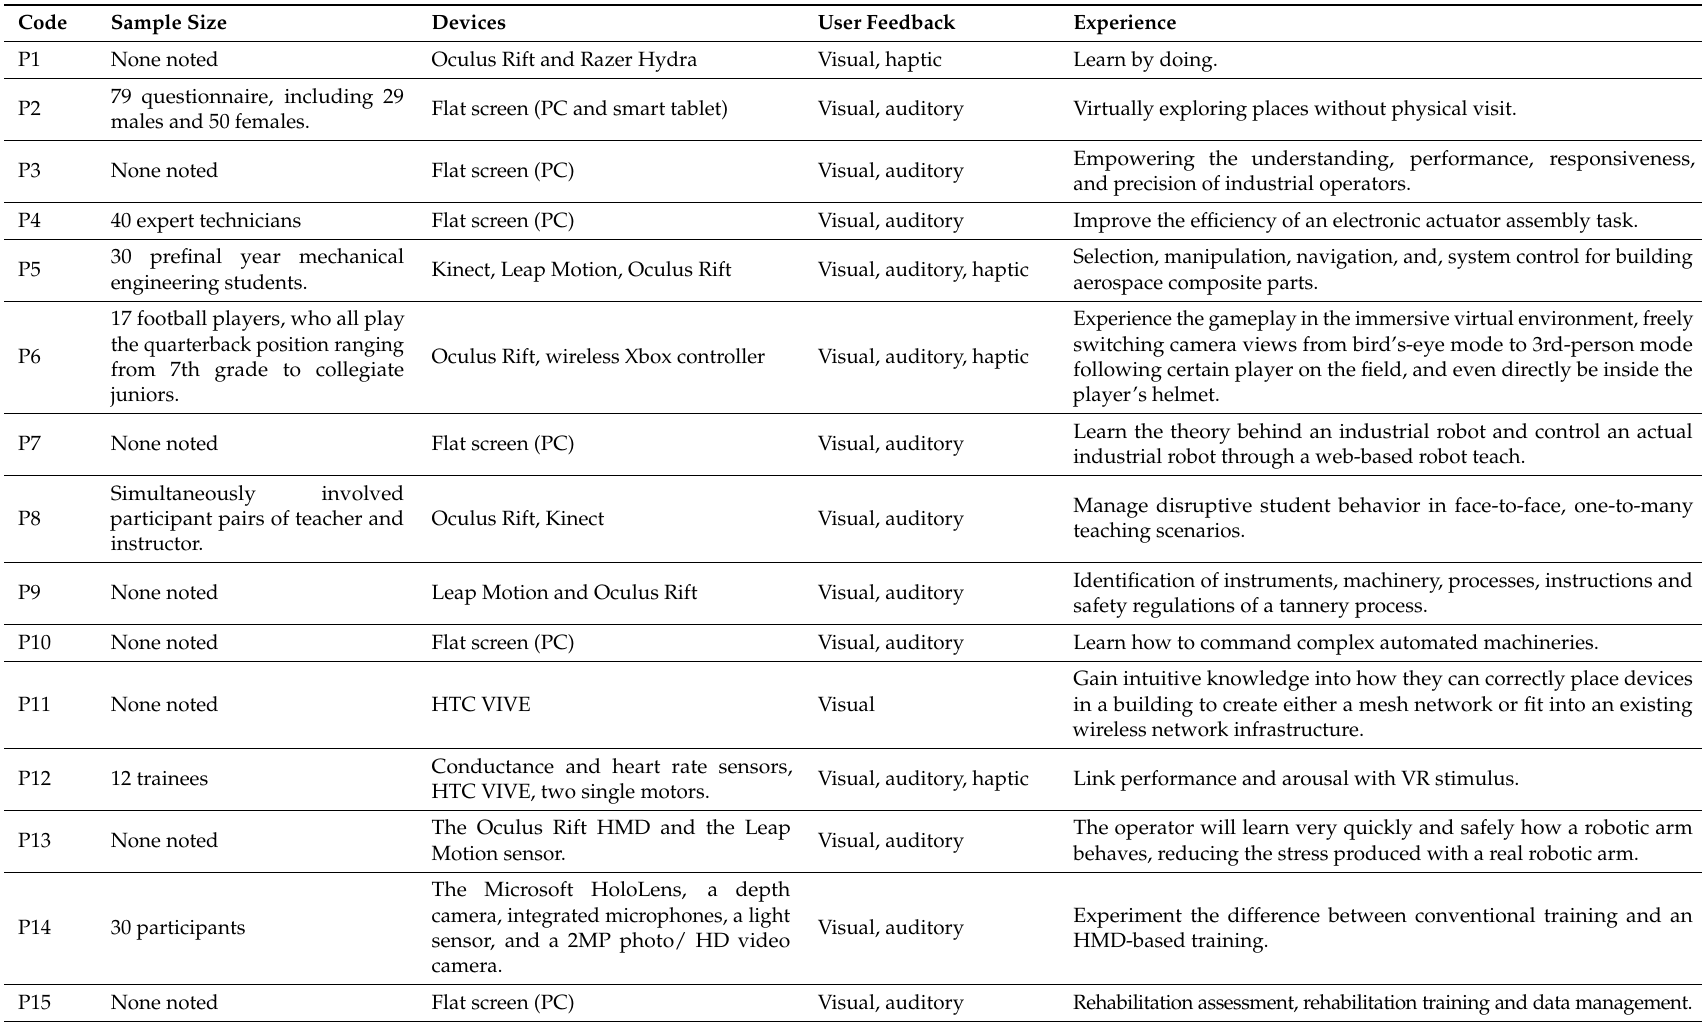
Table 4. Characteristics of the included